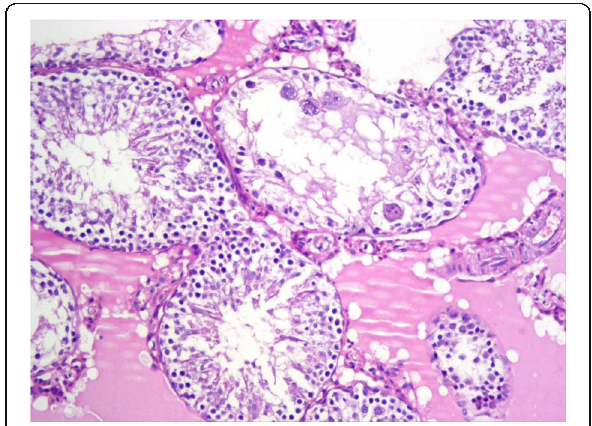
Fig. 4 Testicular section from the tramadol group showing focal vacuolar degeneration with prominent intratubular giant cells and interstitial oedema (H & E, × 200)